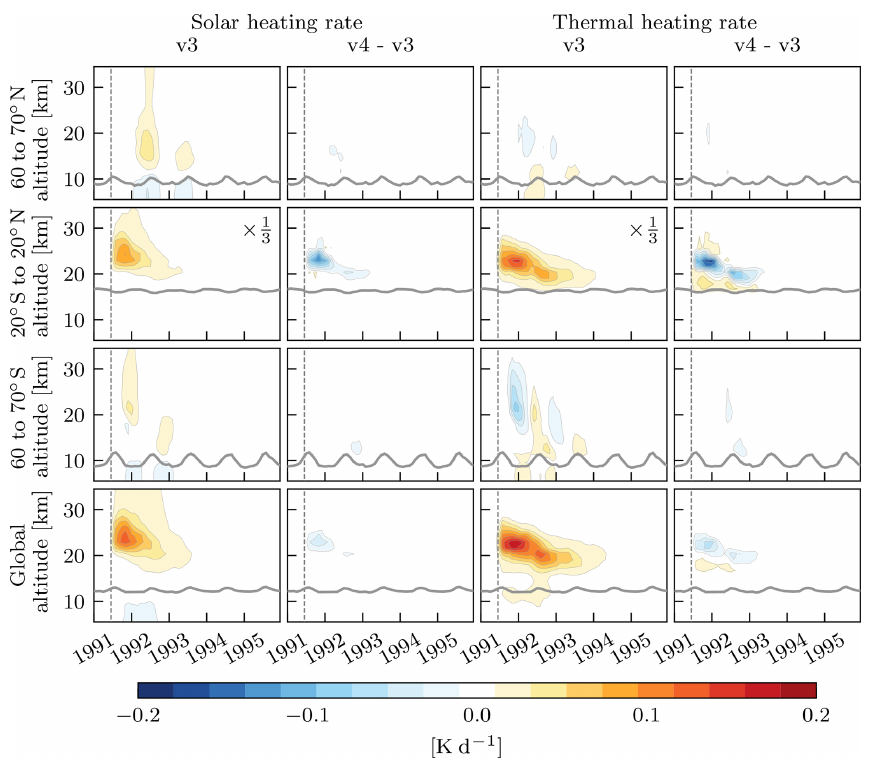
Figure 4. Instantaneous heating rates from CanESM5 model runs. The first column shows the instantaneous solar heating rate due to strato- spheric aerosols using the version 3 forcing dataset. The second column shows the change in the instantaneous solar heating rate when version 4 is used instead. The third and fourth columns show the same, except for the instantaneous thermal heating rates. The gray lines denote the tropopause, and dashed lines indicate the date of the Pinatubo eruption. Note that the v3 instantaneous heating rates in the tropics have been multiplied by one-third for visual